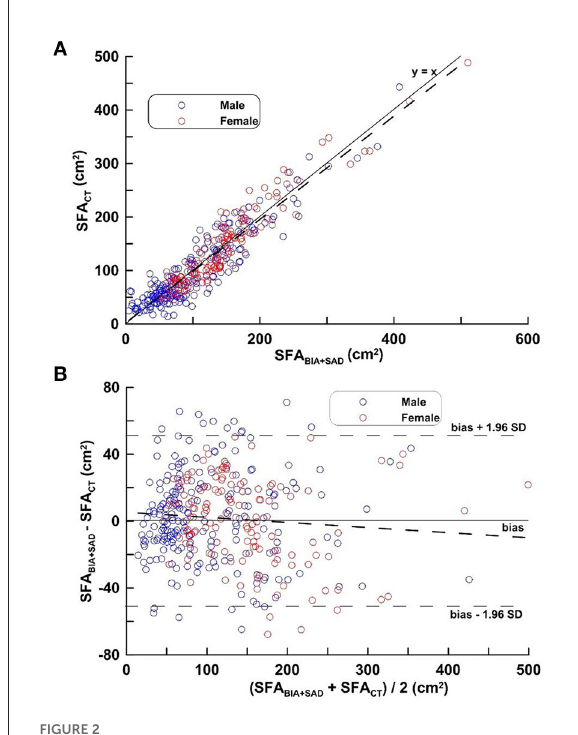
FIGURE3 (A,B) Correlation analysis (top) and difference analysis (bottom) of SFA in the validation group on SFA CT , bioimpedance and SAD. The difference (calculated SFA CT -SFA BIA + SAD on Bland-Altman) is the mean of the corresponding measurements of SFA on CT and BIA + SAD ( y = 13.33 − 0.035, p = 0.193). Blue circles represent males and red circles represent